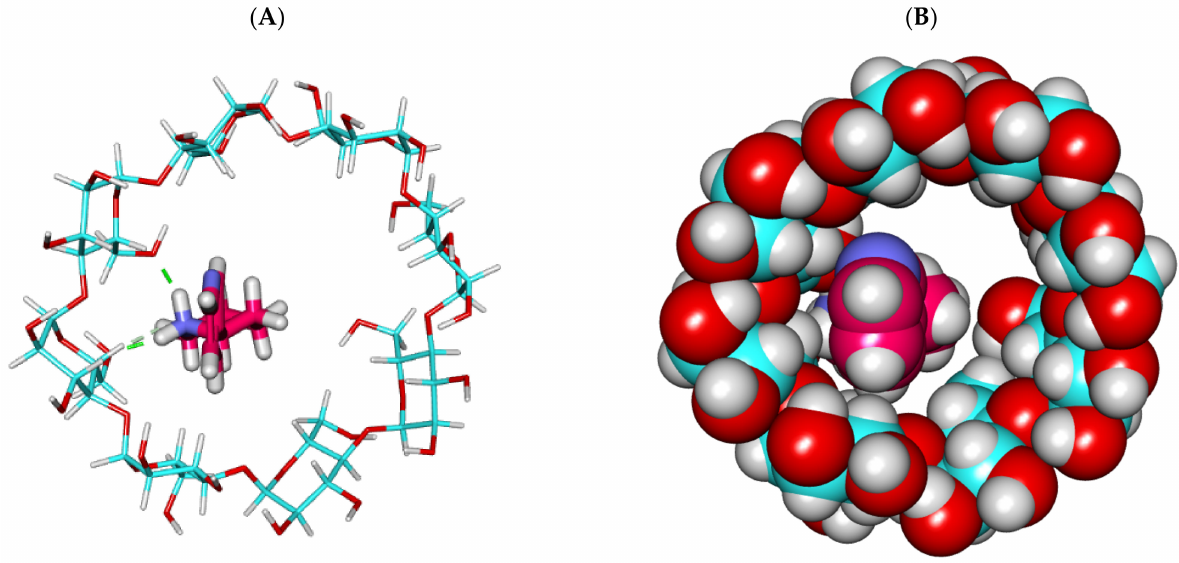
Figure 6. The best-ranked docking poses of anabasine with γ CD, top view, as sticks ( A ), and CPK ( B